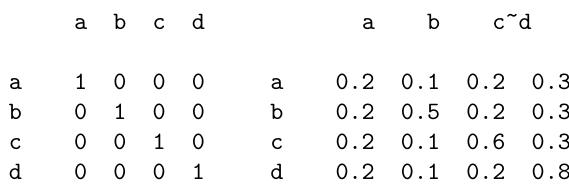
Figure 8. Example of a letter-confusion matrix for the alphabet of symbols a, b, c, and d for Levenshtein distance (left) and arbitrary letter confusion matrix (right): the matrix gives a weight of transcription of the letter in the vertical axis to the letter in the horizontal